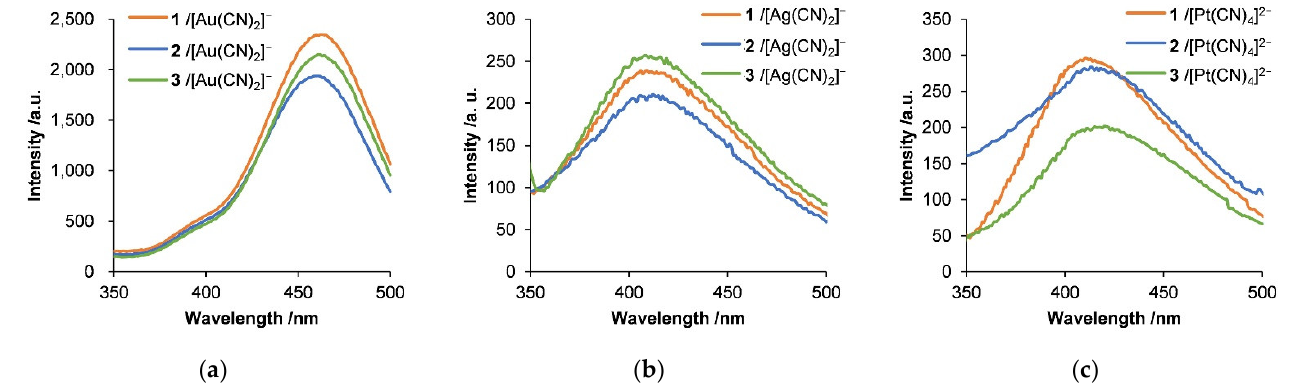
Figure 9. Emission spectra of hybrids of ( a ) [Au(CN) 2 ] − , ( b ) [Ag(CN) 2 ] − , and ( c ) [Pt(CN) 4 ] 2− with diblock copolypeptide amphiphiles 1–3, where [Au(CN) 2 ] − = 3.5 mM, [Ag(CN) 2 ] − = 5.0 mM, and [Pt(CN) 4 ] 2− = 2.7 mM. Excitation wavelength = 335 nm.